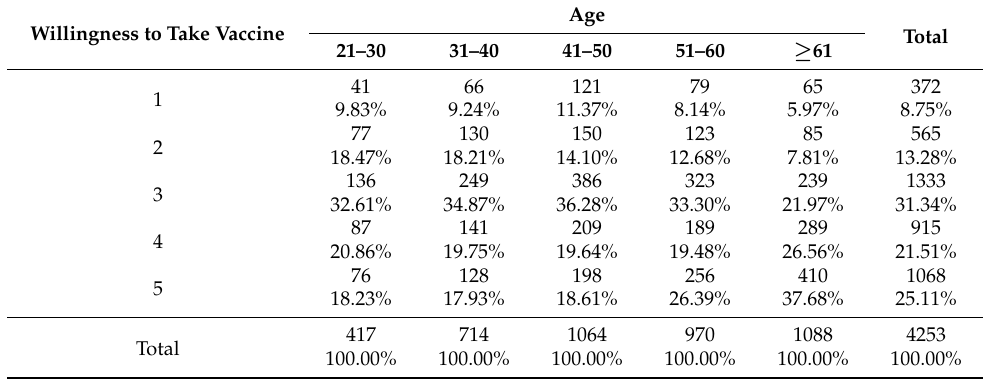
Table 3. Distribution of willingness to take vaccine by age group.